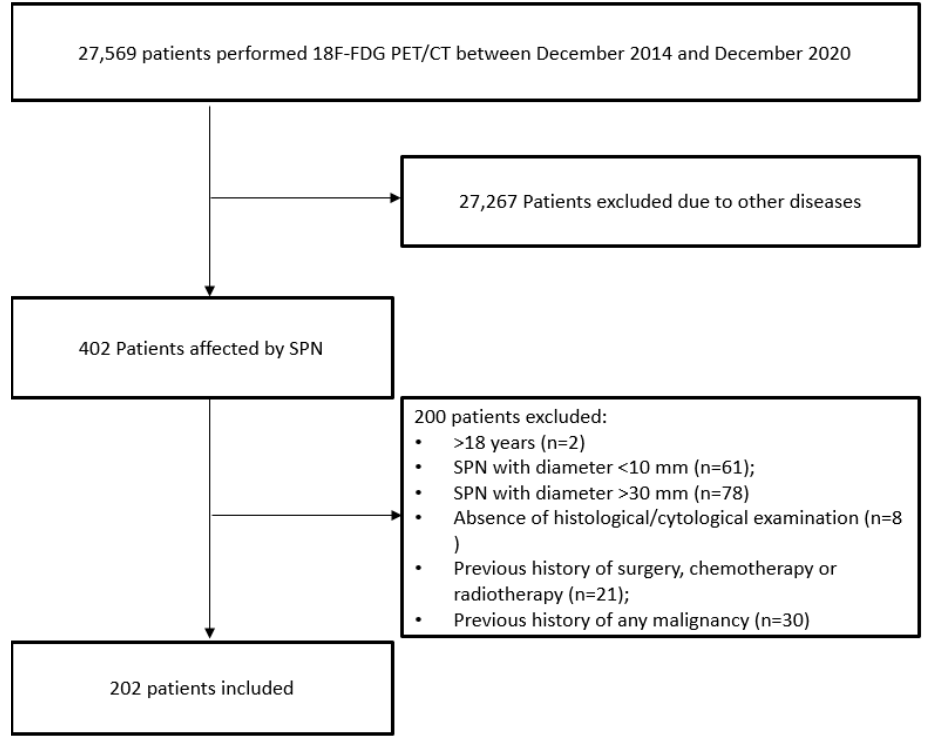
Figure 1. Flowchart of patients included. SPN: solitary pulmonary nodule.